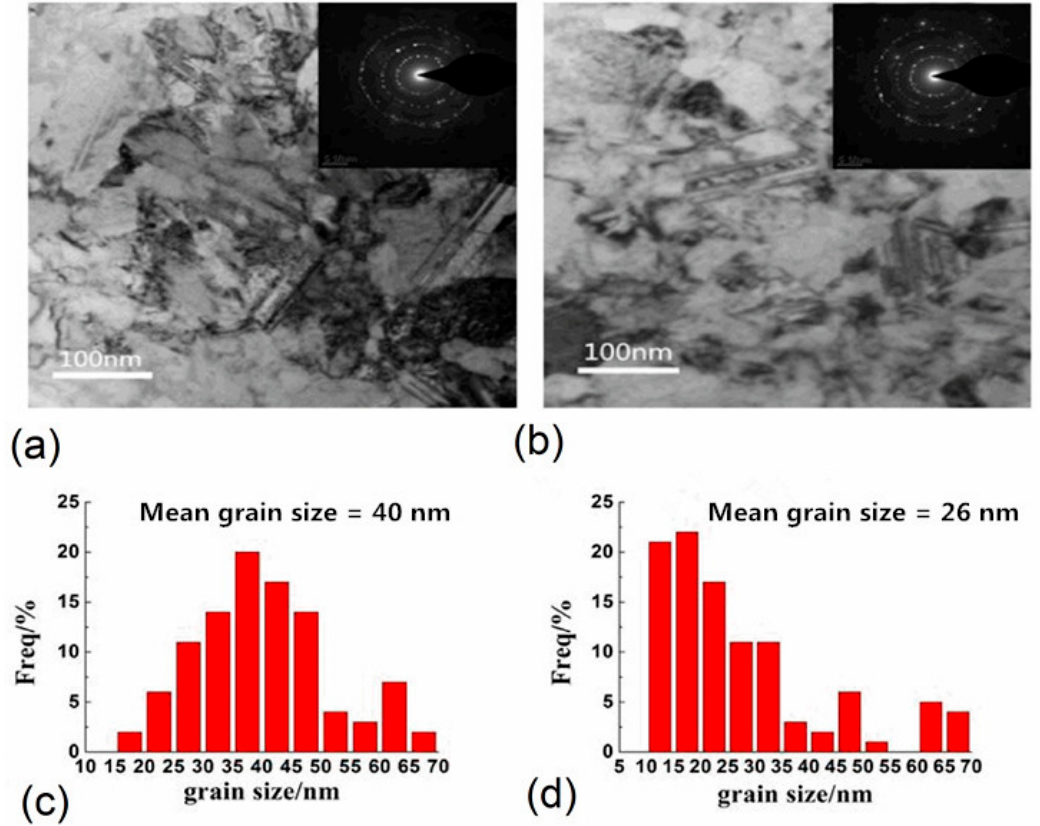
Figure 5. TEM bright-field images, selected area electron diffraction, and grain size distribution of the nickel coatings: ( a ) and ( b ) for the coating deposited at 2.0 A·dm − 2 ; ( c ) and ( d ) for the coating deposited at 4.0 A·dm − 2 .